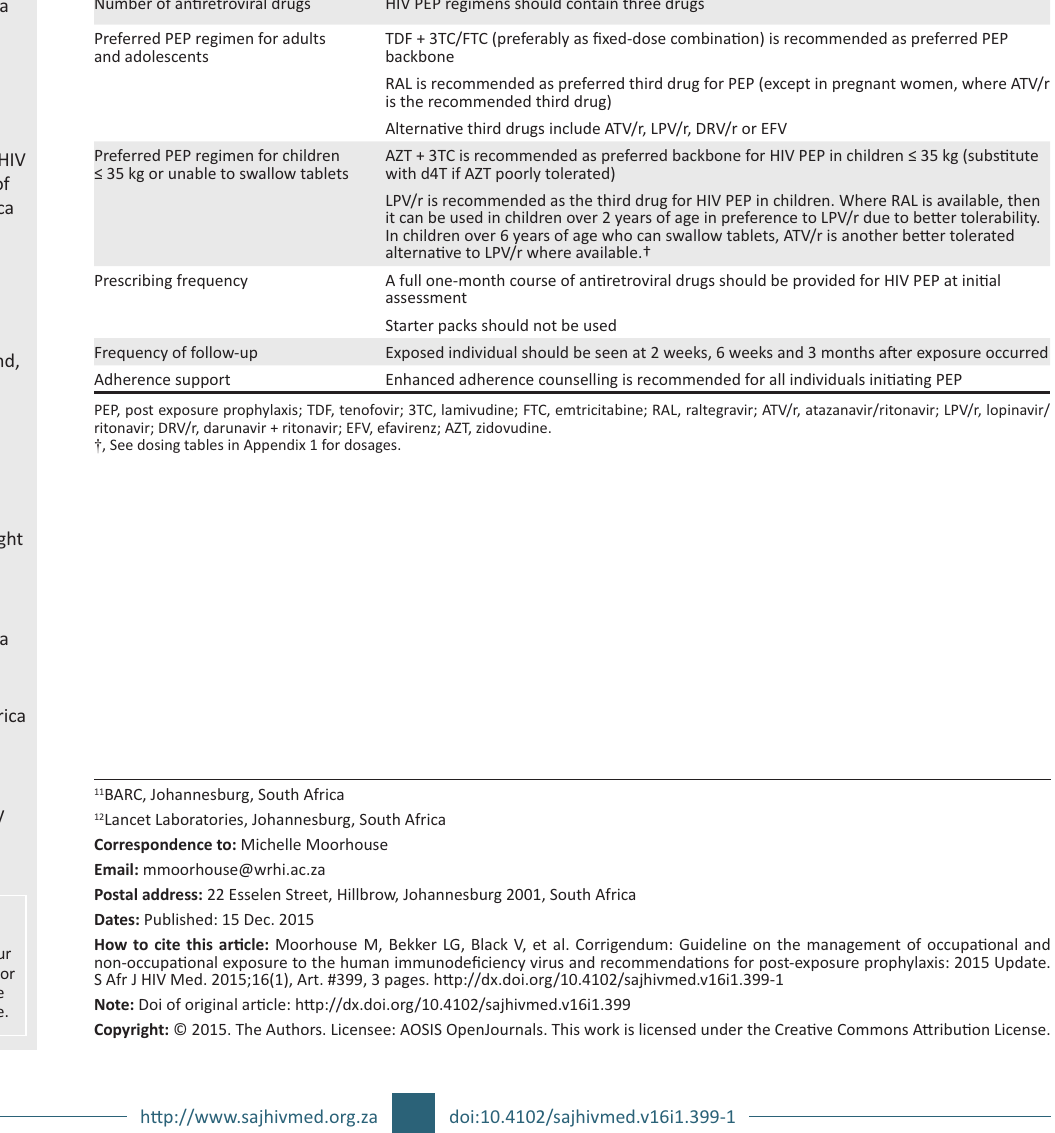
TABLE 1: Summary of guidelines on post-exposure prophylaxis for HIV in adults, adolescents and children. Guideline Recommendation Number of antiretroviral drugs HIV PEP regimens should contain three drugs Preferred PEP regimen for adults and